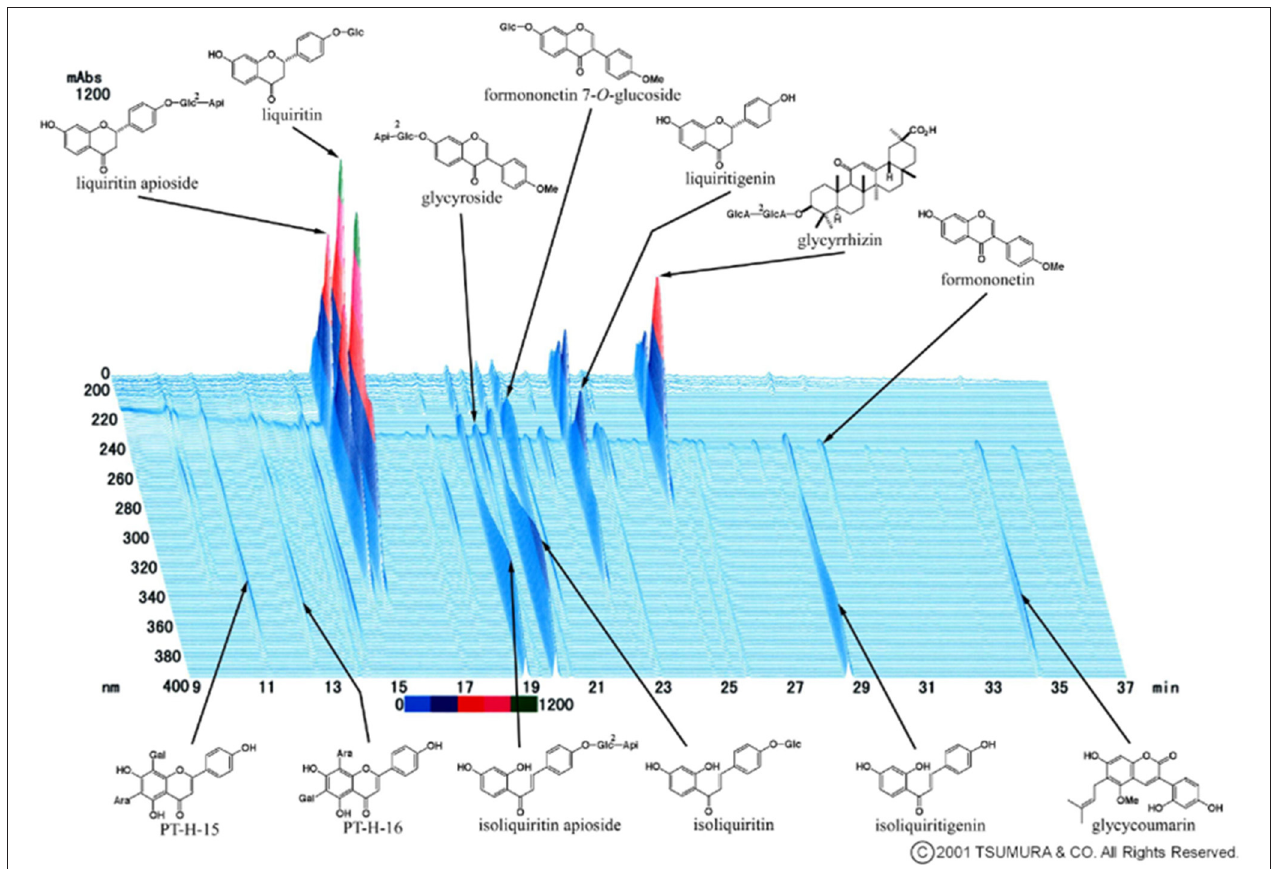
FIGURE 3 | 3D HPLC Pattern of Kambakutaisoto. 3D-HPLC (High Performance Liquid Chromatography) fingerprint evaluation of Kambakutaisoto. Using this method, the equivalence of herbal preparations consisting of botanical crude drugs is